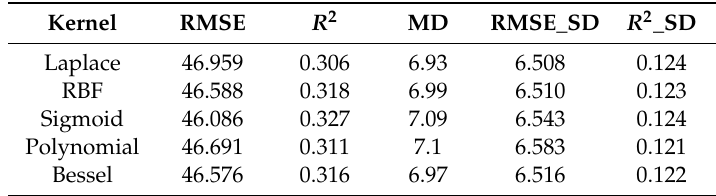
Figure 5. MD plot for different experiments.